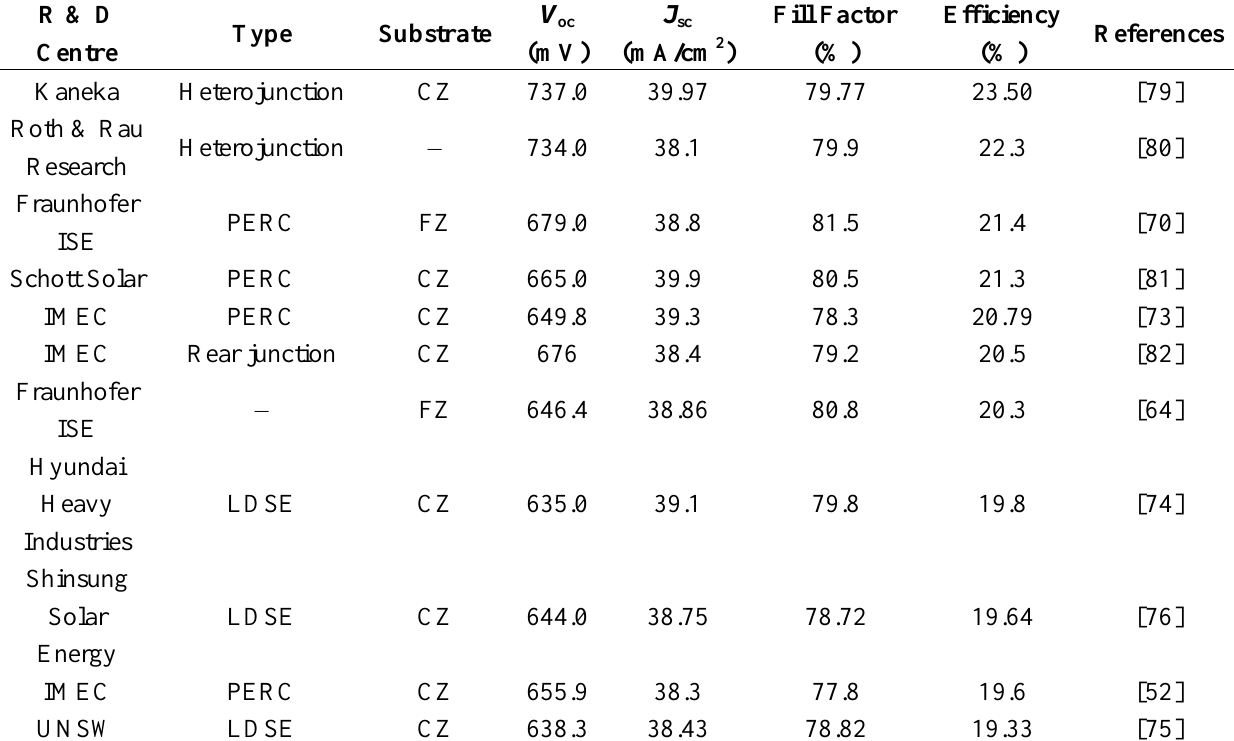
Table 4. Optimal results for various high efficiency cell structures with front side metallized by the LIP based Cu plating